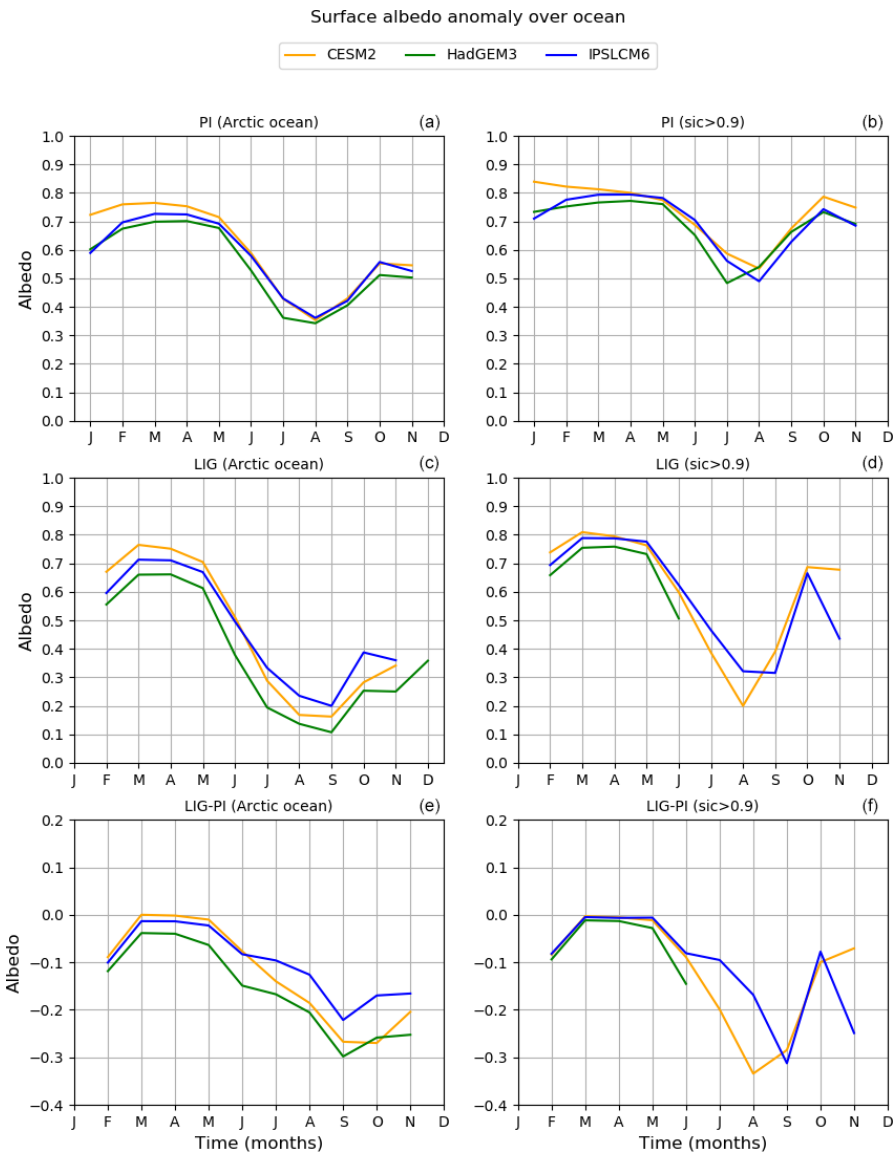
Figure 9. Albedo over the Arctic for PI (a, b) , LIG (c, d) and LIG–PI (e, f) for HadGEM3, IPSL-CM6 and CESM2. The albedo has been recomputed from the SWup and SWdn fluxes. Panels (a) , (c) and (e) show the results for the whole Arctic, while panels (b) , (d) and (f) show the results for areas where the sea ice fraction is larger than 0.9. All LIG values have been calendar